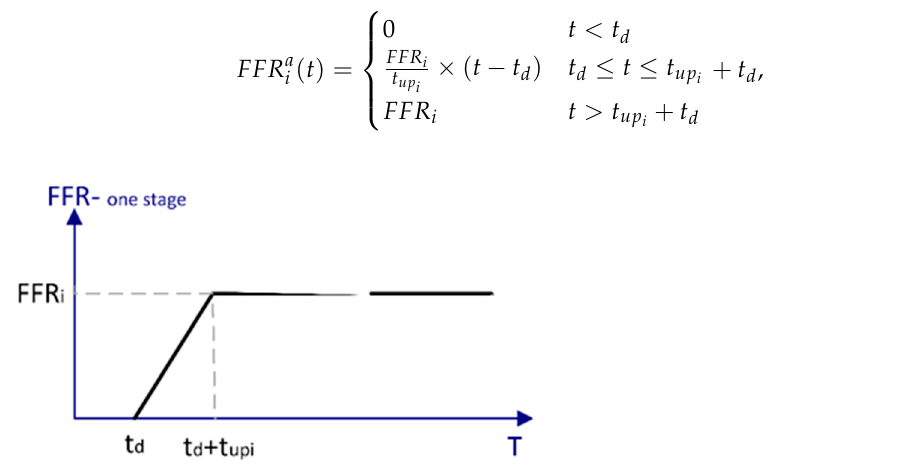
Figure 9. The provision of FFR in one stage.